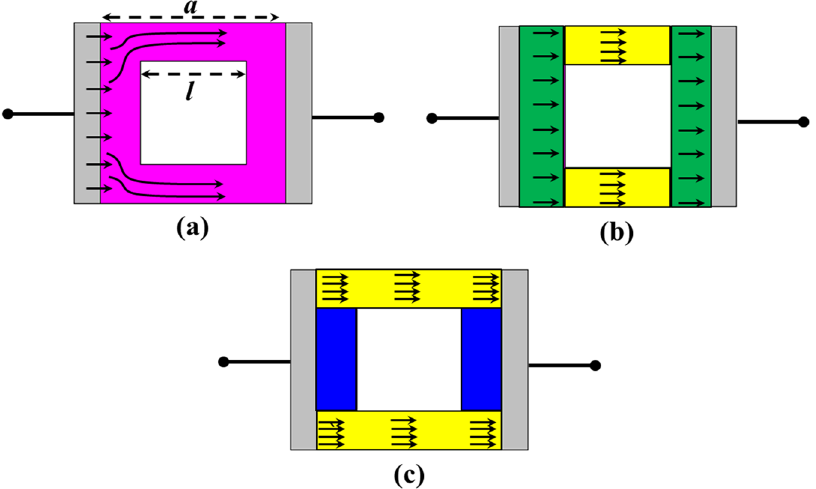
Figure 2. ( a ) Illustration of the current redistribution around the corners of the surface. ( b ) Lower bound case: the surface resistance of both ends (green areas) is R s ( a − l )/ a , and the surface resistance of the two side sheets (yellow areas) is R s l /( a − l ). (c) Upper bound case: the surface resistance of the two long sheets (yellow area) is R s a /( a − l) with no surface current in the blue